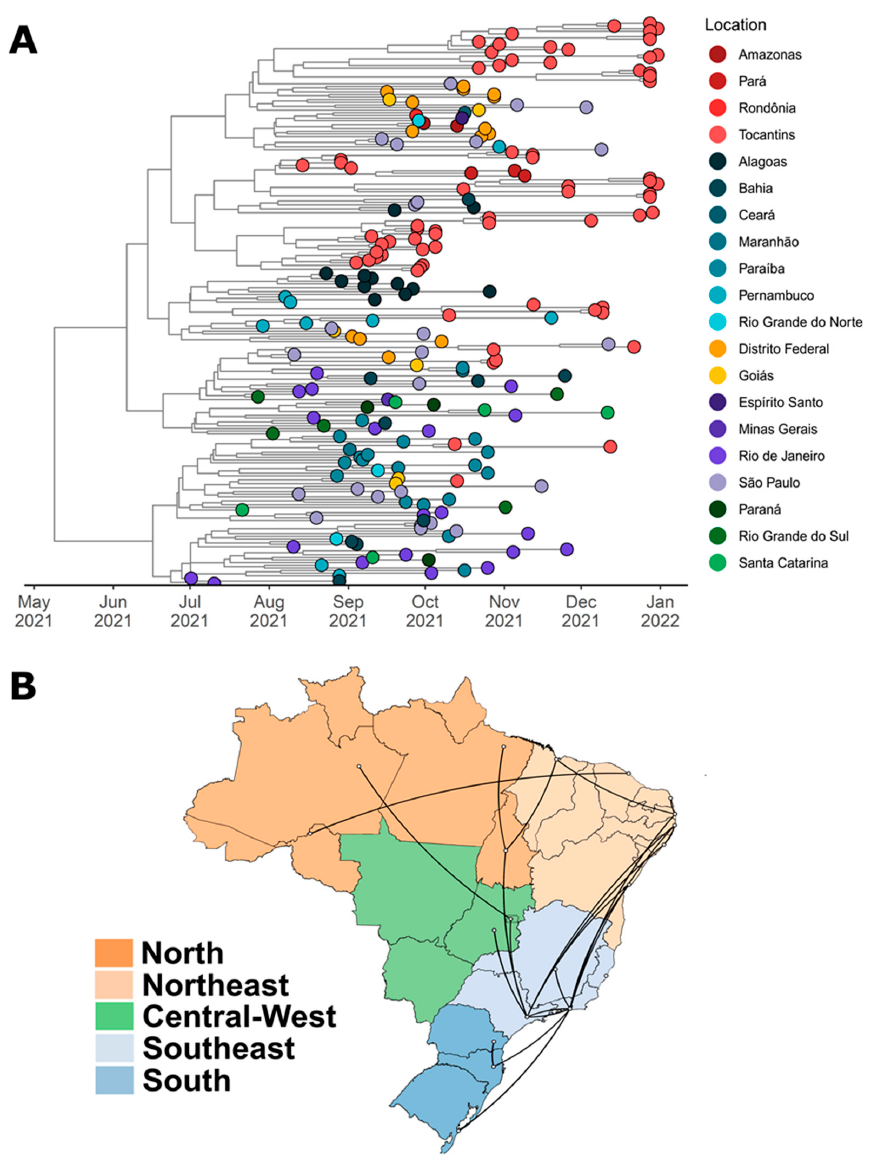
Figure 7. ( A ) Bayesian time-scale phylogeny of 214 AY.99.2 samples circulating in Brazil from 5 July 2021 to 16 December 2021. Tips are colored based on sampling location, following the legend’s colors on the right. The molecular clock was inferred using BEAST with the HKY + G evolution model and a strict molecular clock (initial evolutionary rate was set to 8 × 10 − 4 substitutions/site/year). ( B ) Spatiotemporal diffusion of the filtered AY.99.2 subclade across the Brazilian states. The figure shows well-supported transition rates of the AY.99.2 lineage between Brazilian regions in discrete phylogeographic reconstructions using BSSVS procedure and Bayes Factor